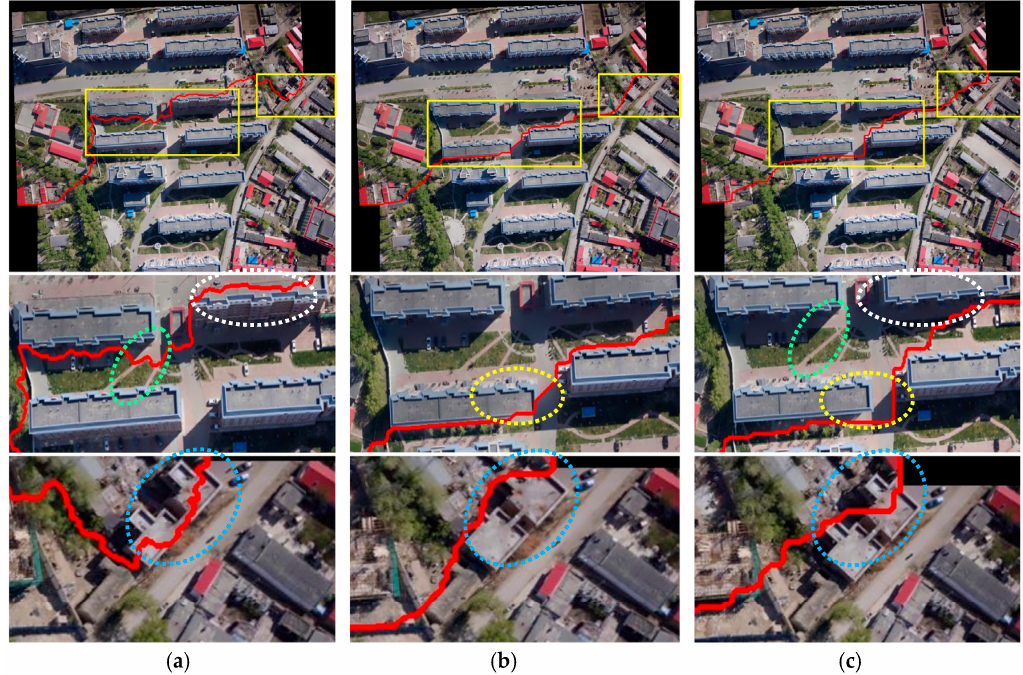
Figure 10. Optimal seam-lines of three test methods for Figure 5d. ( a ) GCC. ( b ) GCCG. ( c ) GCCGOF.